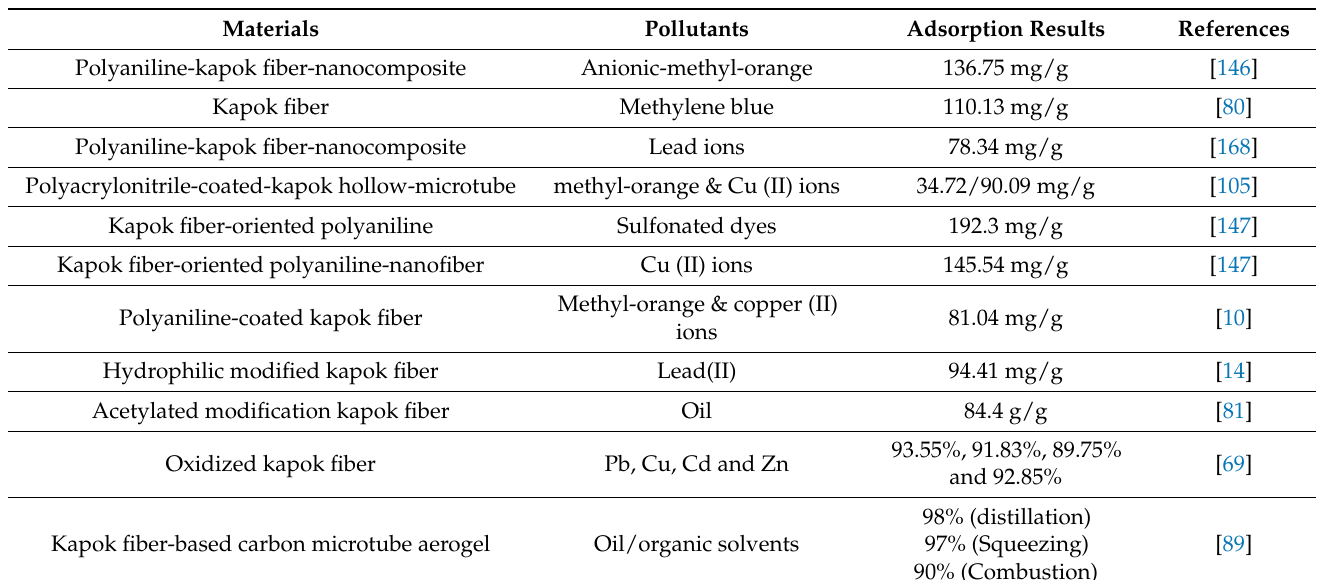
Table 2. Summary of adsorption application of Kapok